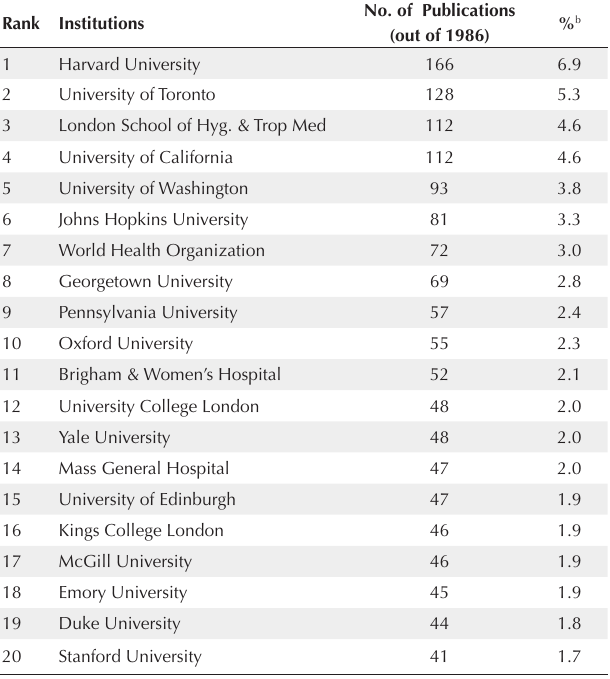
Table 2. Institutions with the highest number of co-authorships a